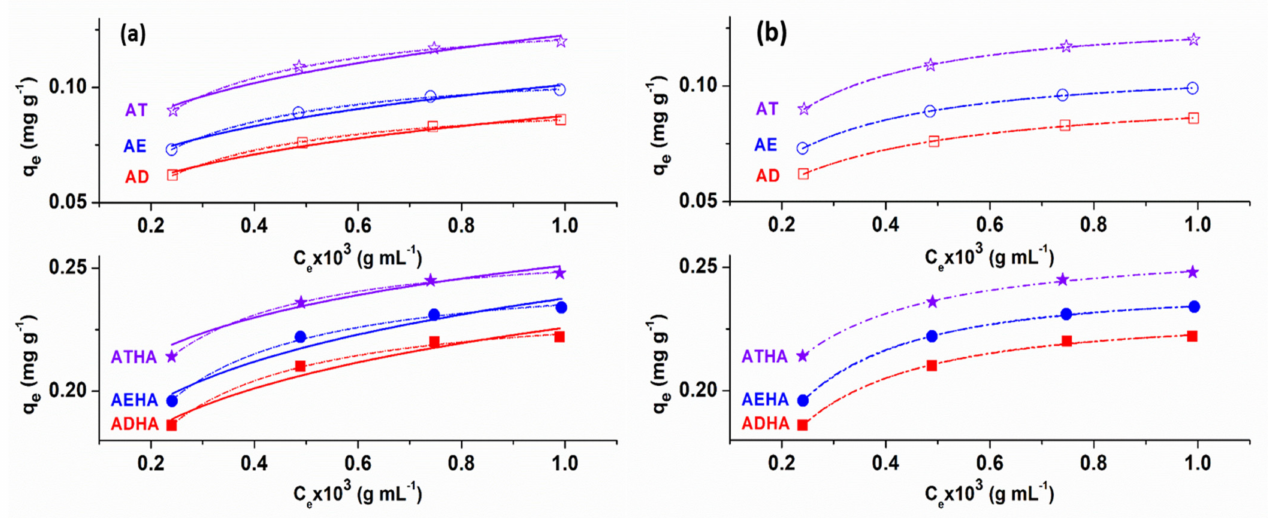
Figure 13. The results of nonlinear fits of Langmuir (dash line); Freundlich (solid line); Dubinin– Radushkevich (short dot line) ( a ); Sips (dash dot line); and Khan (short dash line). ( b ) Isotherm for